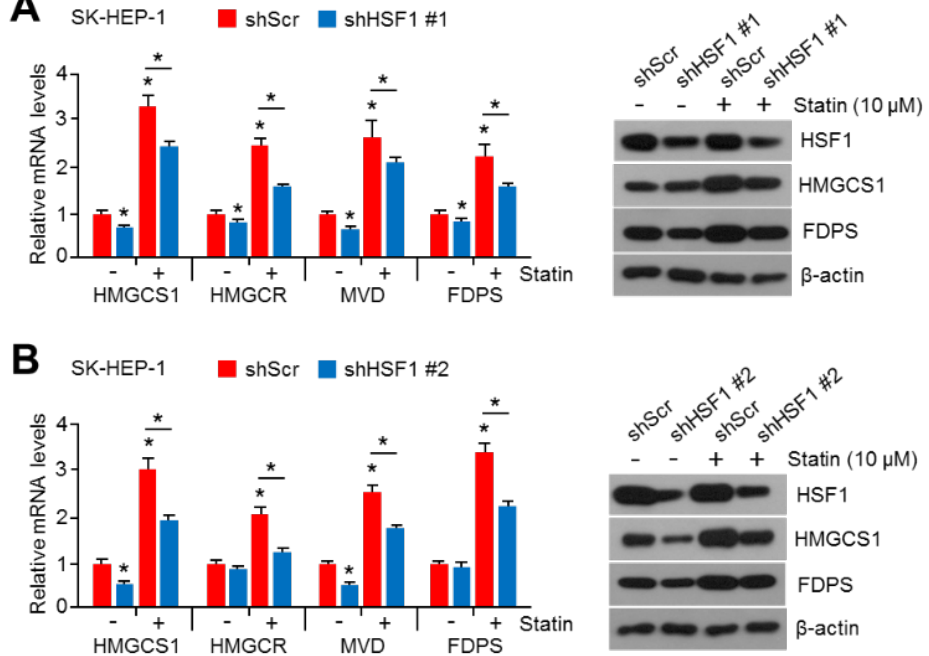
Figure 2. Heat shock factor 1 (HSF1) knock-down decreased mevalonate and cholesterol biosynthesis-related gene expression in HCC cells. ( A , B ) HSF1 knocked-down SK-HEP-1 cells were cultured under simvastatin (10 µ M) treatment for 24 h. The mRNA levels were measured using qRT-PCR. The values represent the mean ± SD of two independent experiments performed in triplicate (* p < 0.05). The protein expression was measured by western blotting.